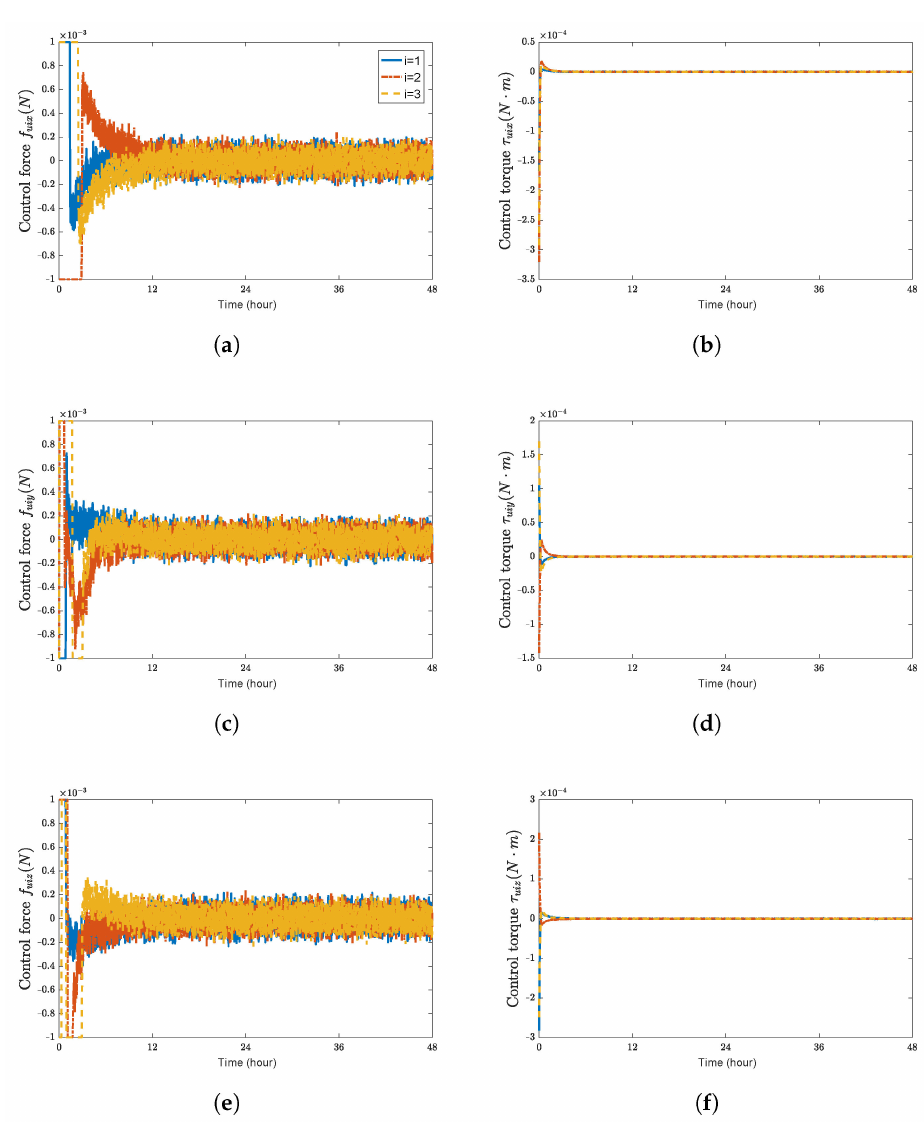
Figure 3. Control forces and control torques of spacecraft SC1 ∼ 3. ( a ) control force f uix ( N ) ; ( b ) control torque τ uix ( N · m ) ; ( c ) control force f uiy ( N ) ; ( d ) control torque τ uiy ( N · m ) ; ( e ) control force f uiz ( N ) ; ( f ) control torque τ uiz ( N · m )